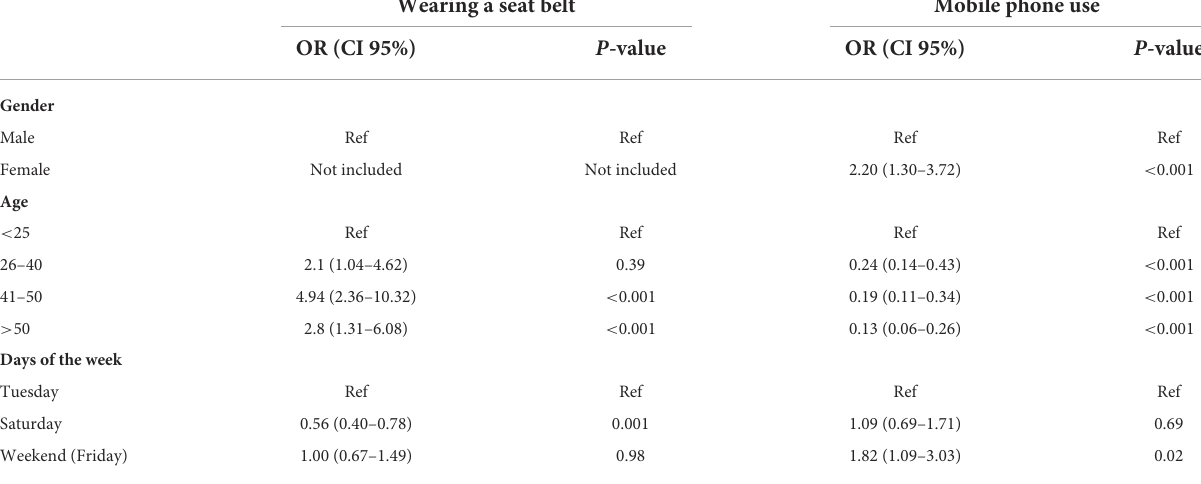
TABLE 4 Binary logistic regression model of the association between wearing seat belts and cell phone use among drivers. Wearing a seat